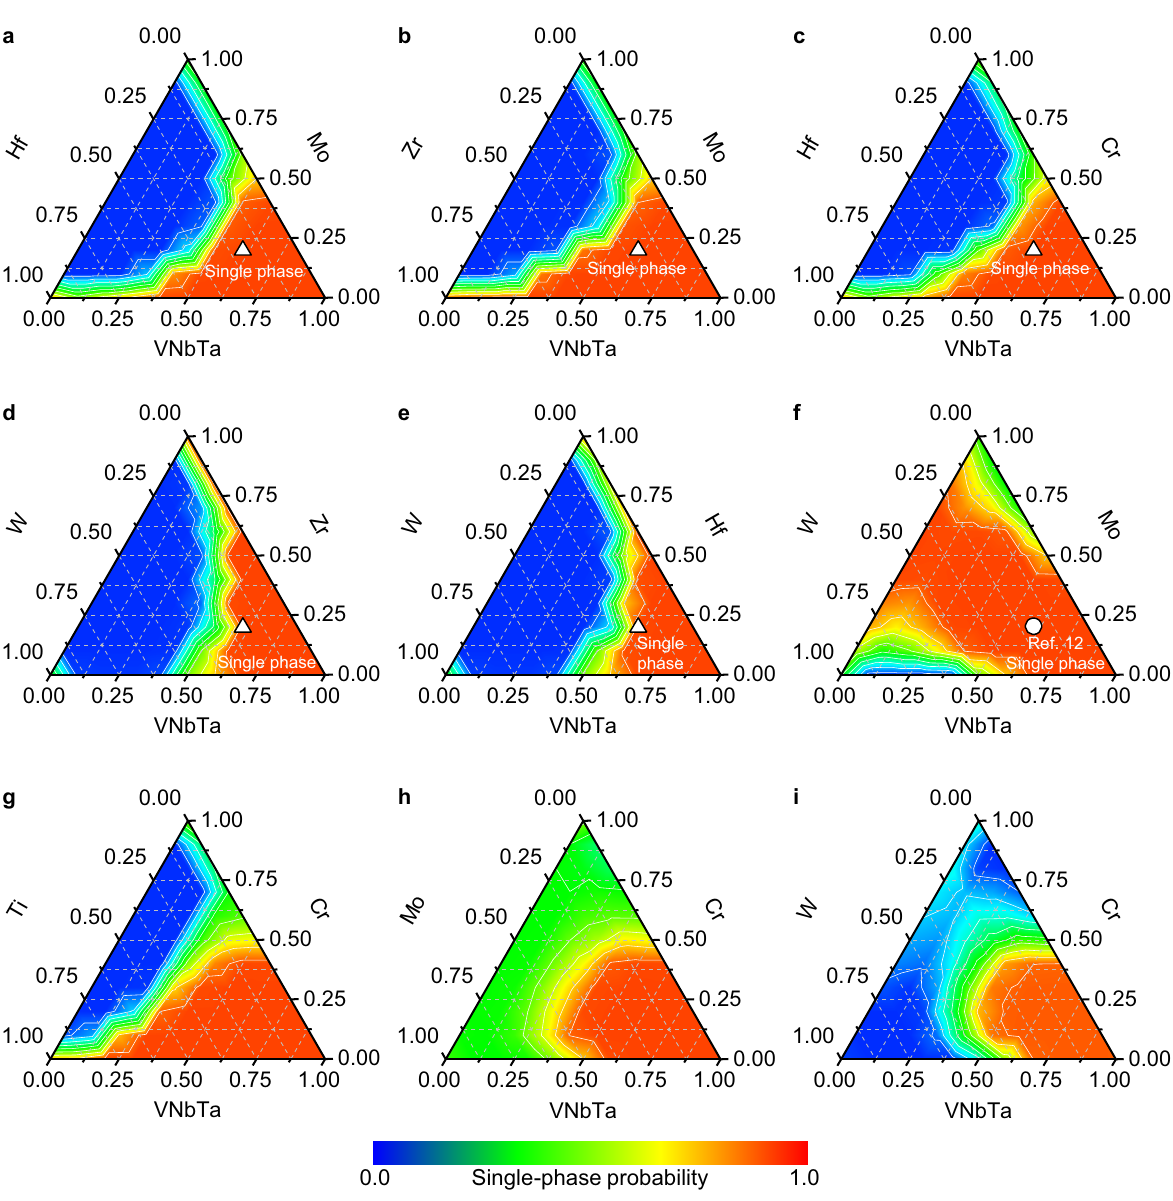
Fig. 6 Phase diagrams of (VNbTa)-based HECCs from ML. a (Hf, Mo, Nb, Ta, V)C 5 . b (Mo, Nb, Ta, V, Zr)C 5 . c (Cr, Hf, Nb, Ta, V)C 5 . d (Nb, Ta, V, W, Zr)C 5 . e (Hf, Nb, Ta, V, W)C 5 . f (Mo, Nb, Ta, V, W)C 5 . g (Cr, Nb, Ta, Ti, V)C 5 . h (Cr, Mo, Nb, Ta, V)C 5 . i (Cr, Nb, Ta, V, W)C 5 . Numbers in each axis denote the atomic percentages in the cation sublattice. Three elements are included in the horizontal axis with equiatomic ratios. Scattered data with triangular and circular labels are experimentally validated by this work and ref. 12 ,